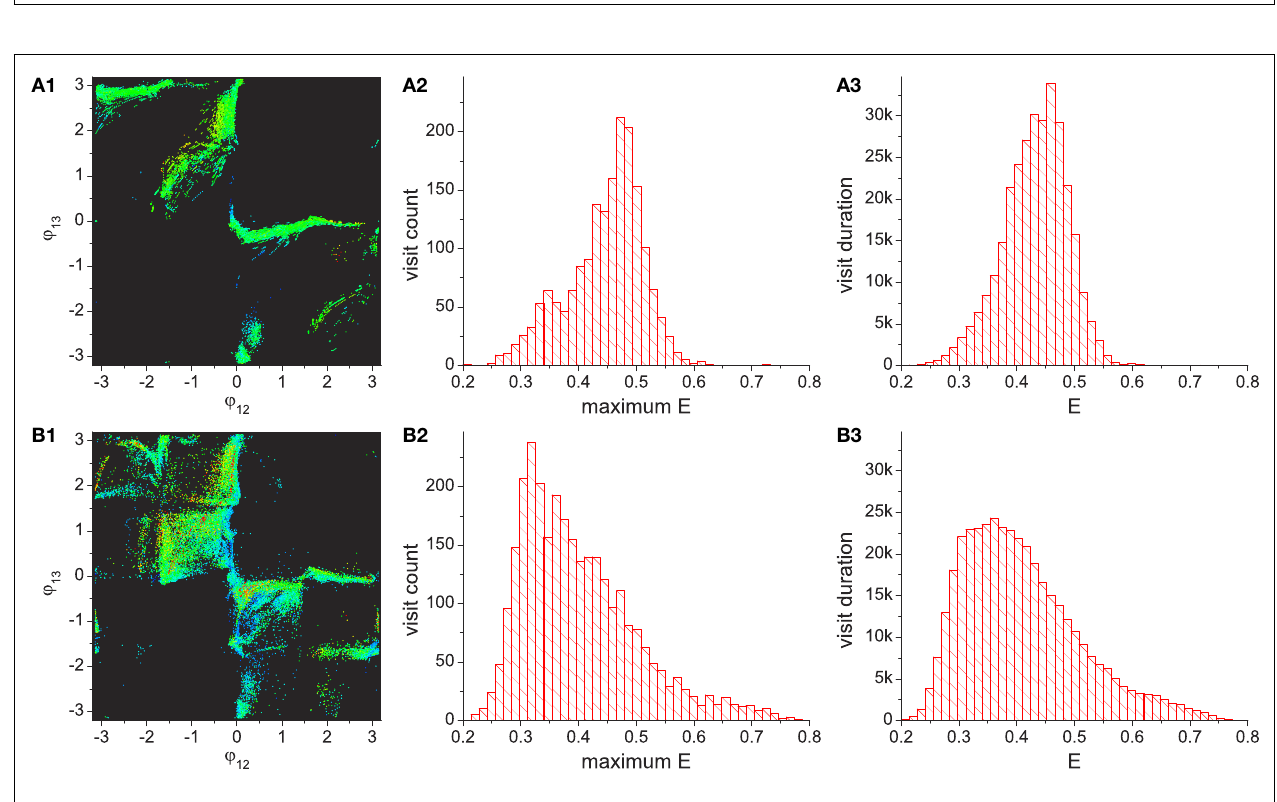
were plotted using colors representing their performance [from blue to red: 0.2 ≤ E ≤ 0.6, black if E < 0.2 (very poor performance), red if high performing ( E > 0.6)]. (A2,A3) and (B2,B3) are histograms representing the visit count and duration for each performance bin.The visit count histogram is produced for the maximum performance reached at each visit